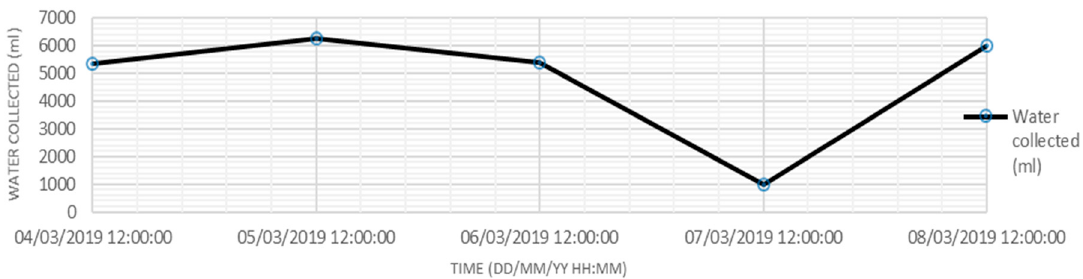
Figure 8. The amount of water collected by the dehumidifier in the first week.